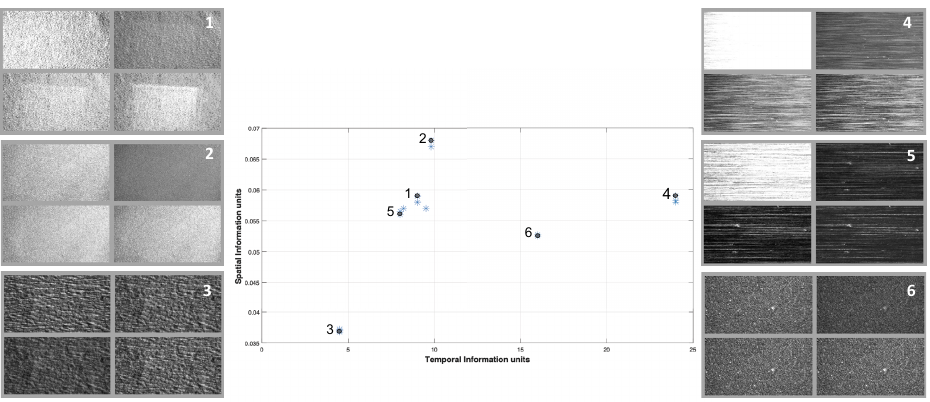
Figure 6. The experiment sequence numbered form 1 to 6 are displayed in the central graph according to their temporal and spatial perceptual information. These six experiment covers the extremal values contained in the whole sequence set as well as some average sequence (1, 5–6). The sequence 2 refers to high spatial perceptual information while the sequence 4 presents high temporal perceptual information. These six sequence are chosen for the training